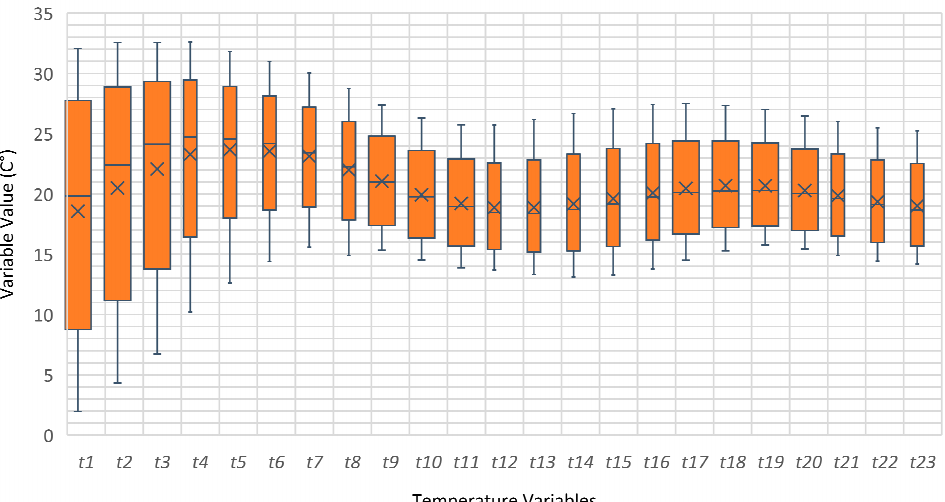
Figure 1. Descriptive statistics of precipitation variables.